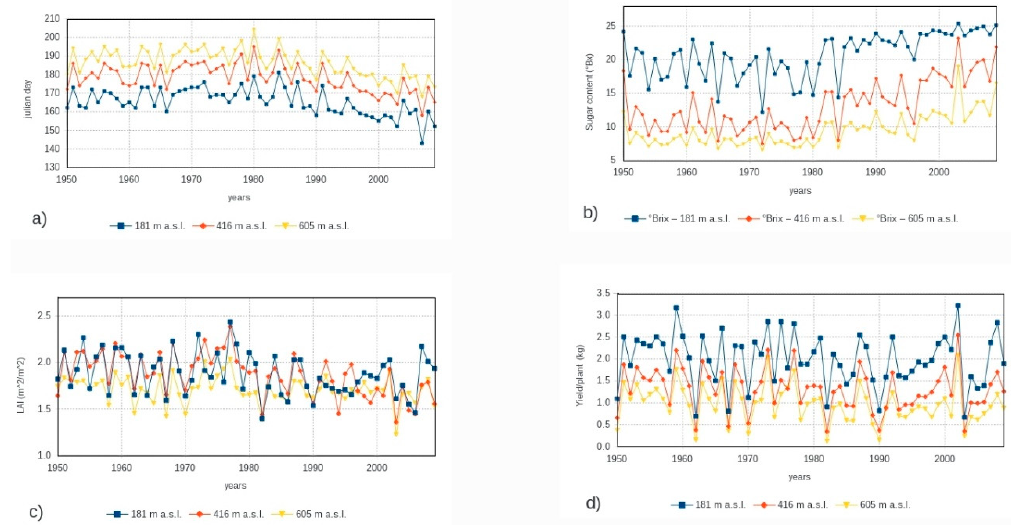
Figure 7. Flowering date (expressed in Julian days) ( a ), berry sugar content ( b ) at the date of 287th Julian day (expressed in ◦ Bx) ( c ), LAI maximum value (expressed in m 2 m − 2 ), and yield per vine (expressed in kg) ( d ), simulated by IVINE in three grid points characterized by different elevation. Cv.: Nebbiolo.